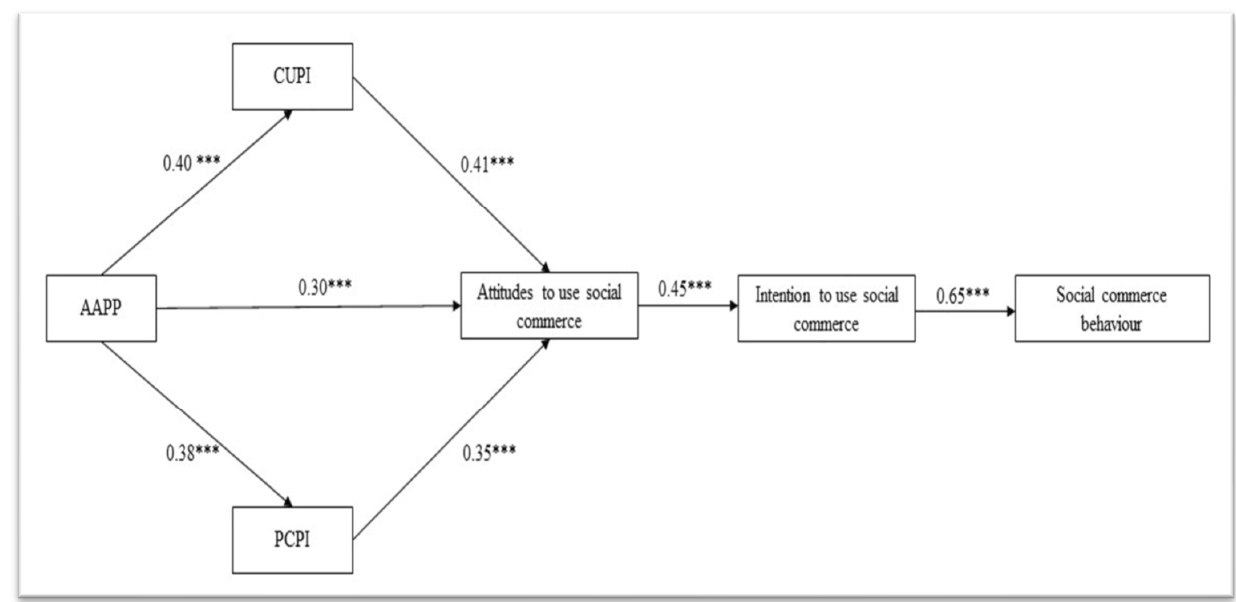
Figure 2. Research model. (Results of structural model evaluation using the whole sample. *** p < 0.01.)